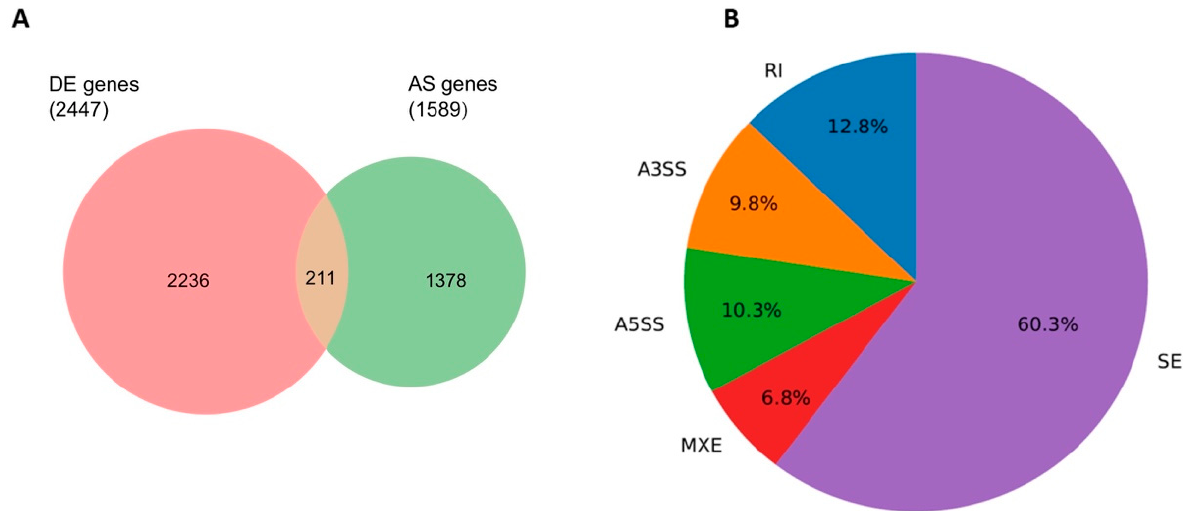
Figure 2. Replicate multivariate analysis of transcript splicing (rMATS). ( A ) Venn diagram comparing differentially expressed (DE) genes (padj < 0.05) and alternatively spliced (AS) genes (FDR < 0.05 or PSI > 0.1). ( B ) Breakdown of average percentages of rMATS splicing changes (events) detected between butyrate dosage of 0 mM and 2.5 mM by type of event (SE = skipped exon, RI = retained intron, MXE = mutually exclusive exon, A5SS = Alt 5 splice site, A3SS = Alt 3 splice site).